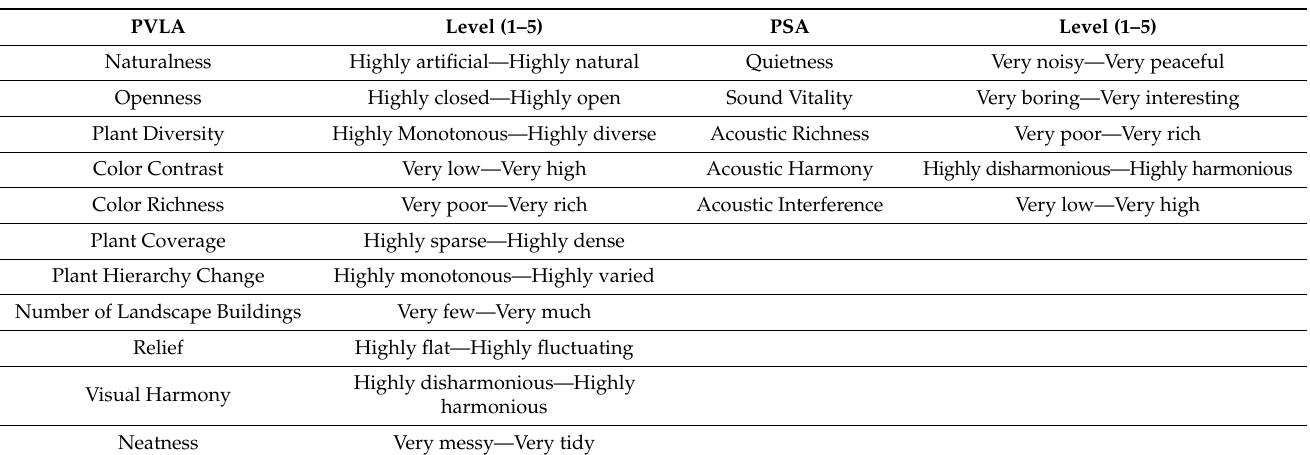
Table 1. Indicators of Perceived Visual Landscape Attributes (PVLA) and Perceived Soundscape Attributes